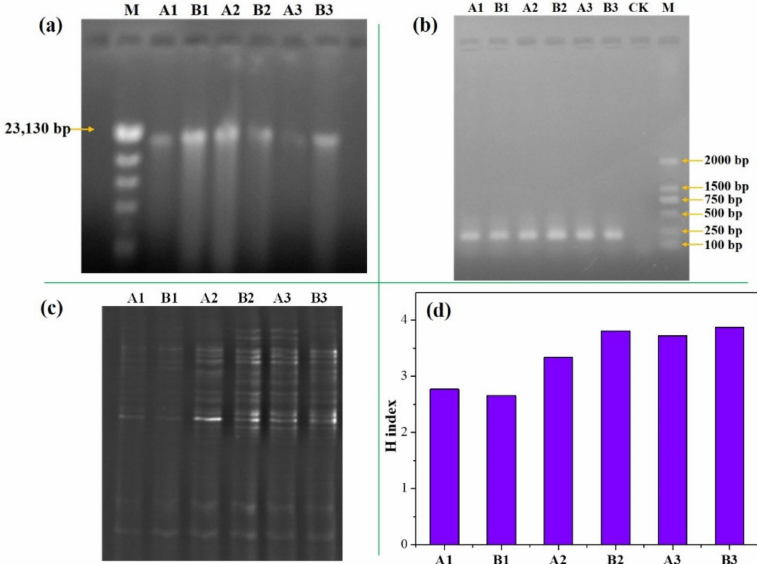
Figure 10. ( a ) The results of the total DNA extraction; ( b ) the results of agarose gel electrophoresis detection; ( c ) the DGGE profile; and ( d ) the diversity index of bacteria in the sediment. (A1: the control sample in the pure oxygen aeration treatment, B1: the control sample in the oxygen enriched water injection treatment, A2: the sample with the pure oxygen aeration treatment, B2: the sample with the oxygen enriched water injection treatment, A3: the sample with the pure oxygen aeration treatment coupled with the addition of exogenous microorganisms, B3: the sample with the oxygen enriched water injection treatment coupled with the addition of exogenous